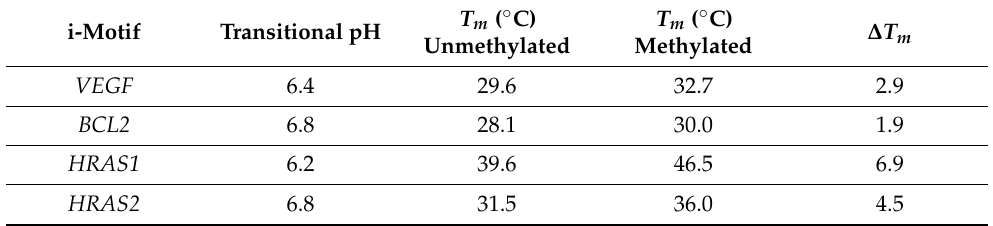
Figure 3. Evaluation of T m for ( A ) VEGF i-motif, ( B ) BCL-2 i-motif, ( C ) HRAS1 i-motif, and ( D ) HRAS2 i-motif. Solid lines indicate unmethylated samples, and dashed lines indicate methylated samples. Table 2. T m of unmethylated and methylated VEGF , BCL-2 , HRAS1 , and HRAS2 i-motif. CpG methylation increased T m values of all i-motif forming DNAs.